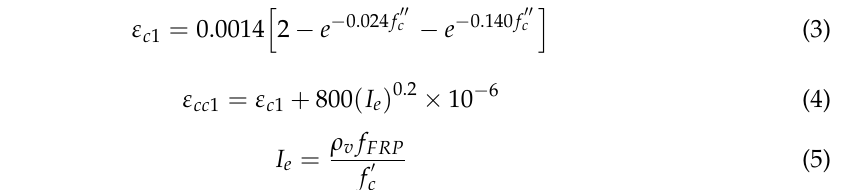
peak strains of unconfined and confined concrete (mm/mm), which are calculated using: